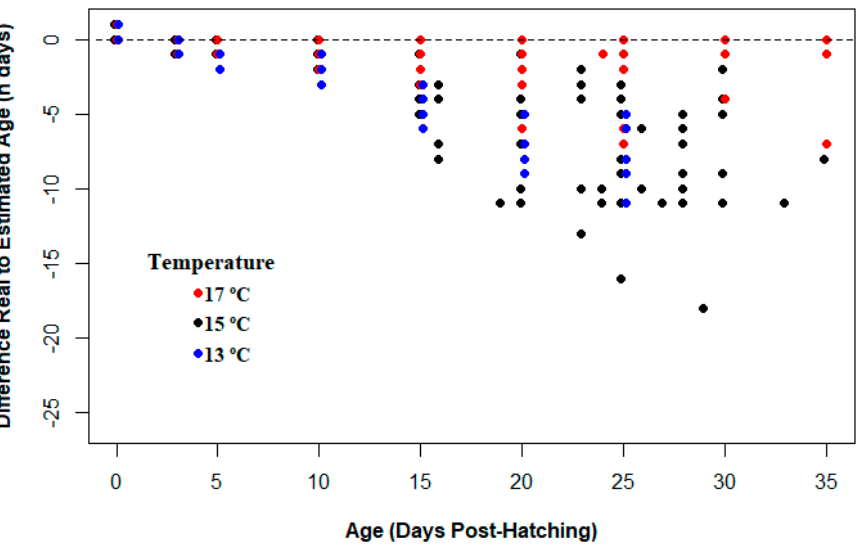
Figure 5. Relationship between European sardine Sardina pilchardus (Walbaum, 1792) larvae age (days post-hatching, dph) and the difference in the number of days between the estimated by growth increment counts and the real age of the larvae reared at 13, 15, and 17 ◦ C. The figure shows data from all the sardine larvae used in the experiment from 0 to 35